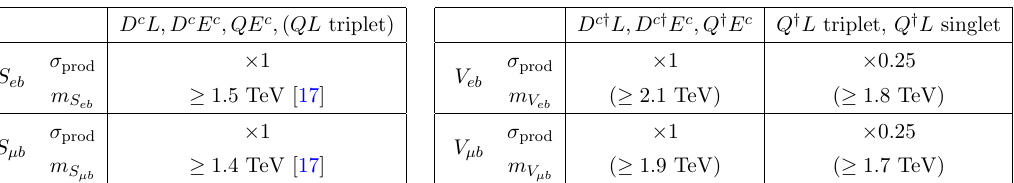
Figure 13 . Bounds on scalar and vector MLQs which decay into ( eb )( eb ) (cid:12)nal states. The 95% CL on the stop/leptoquark mass (black dot) is provided in [17]. The remainder of the analysis is analogous to the right plot of (cid:12)gure 5.